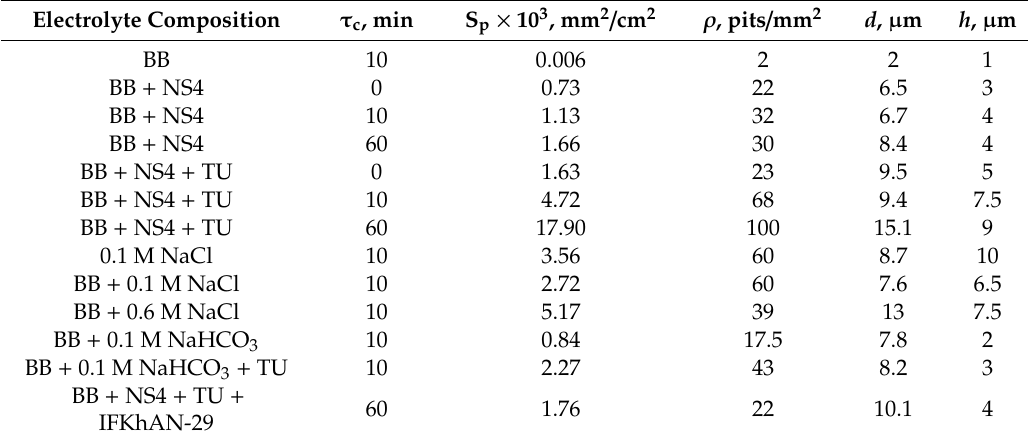
Table 2. Specimen surface characteristics (total area S p , density ρ , mean diameter d and maximum